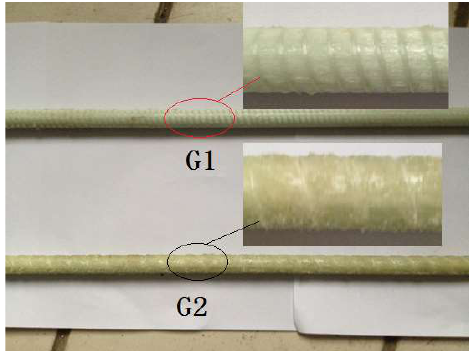
Figure 1. Two types of GFRP ribbed bars.